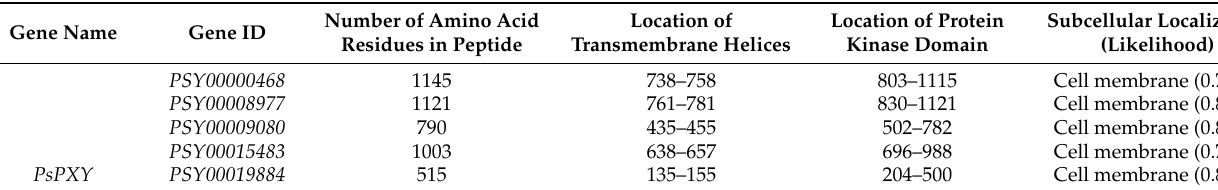
Table 1. Features of the P. sylvestris subgroup XI receptor kinase-like (RLK) family members.